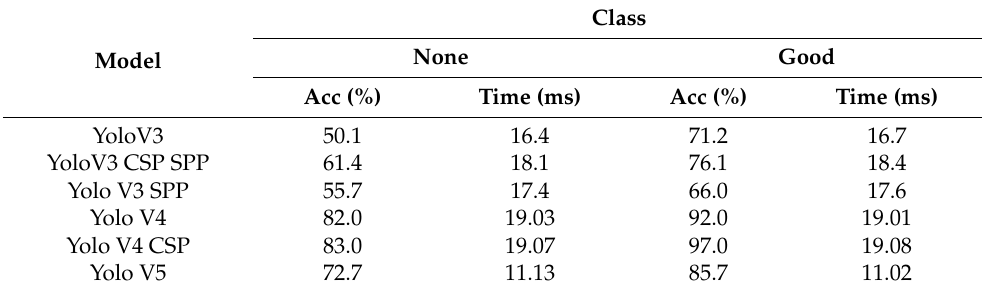
Table 4. The ablation study with COVID Face Mask Detection Dataset.